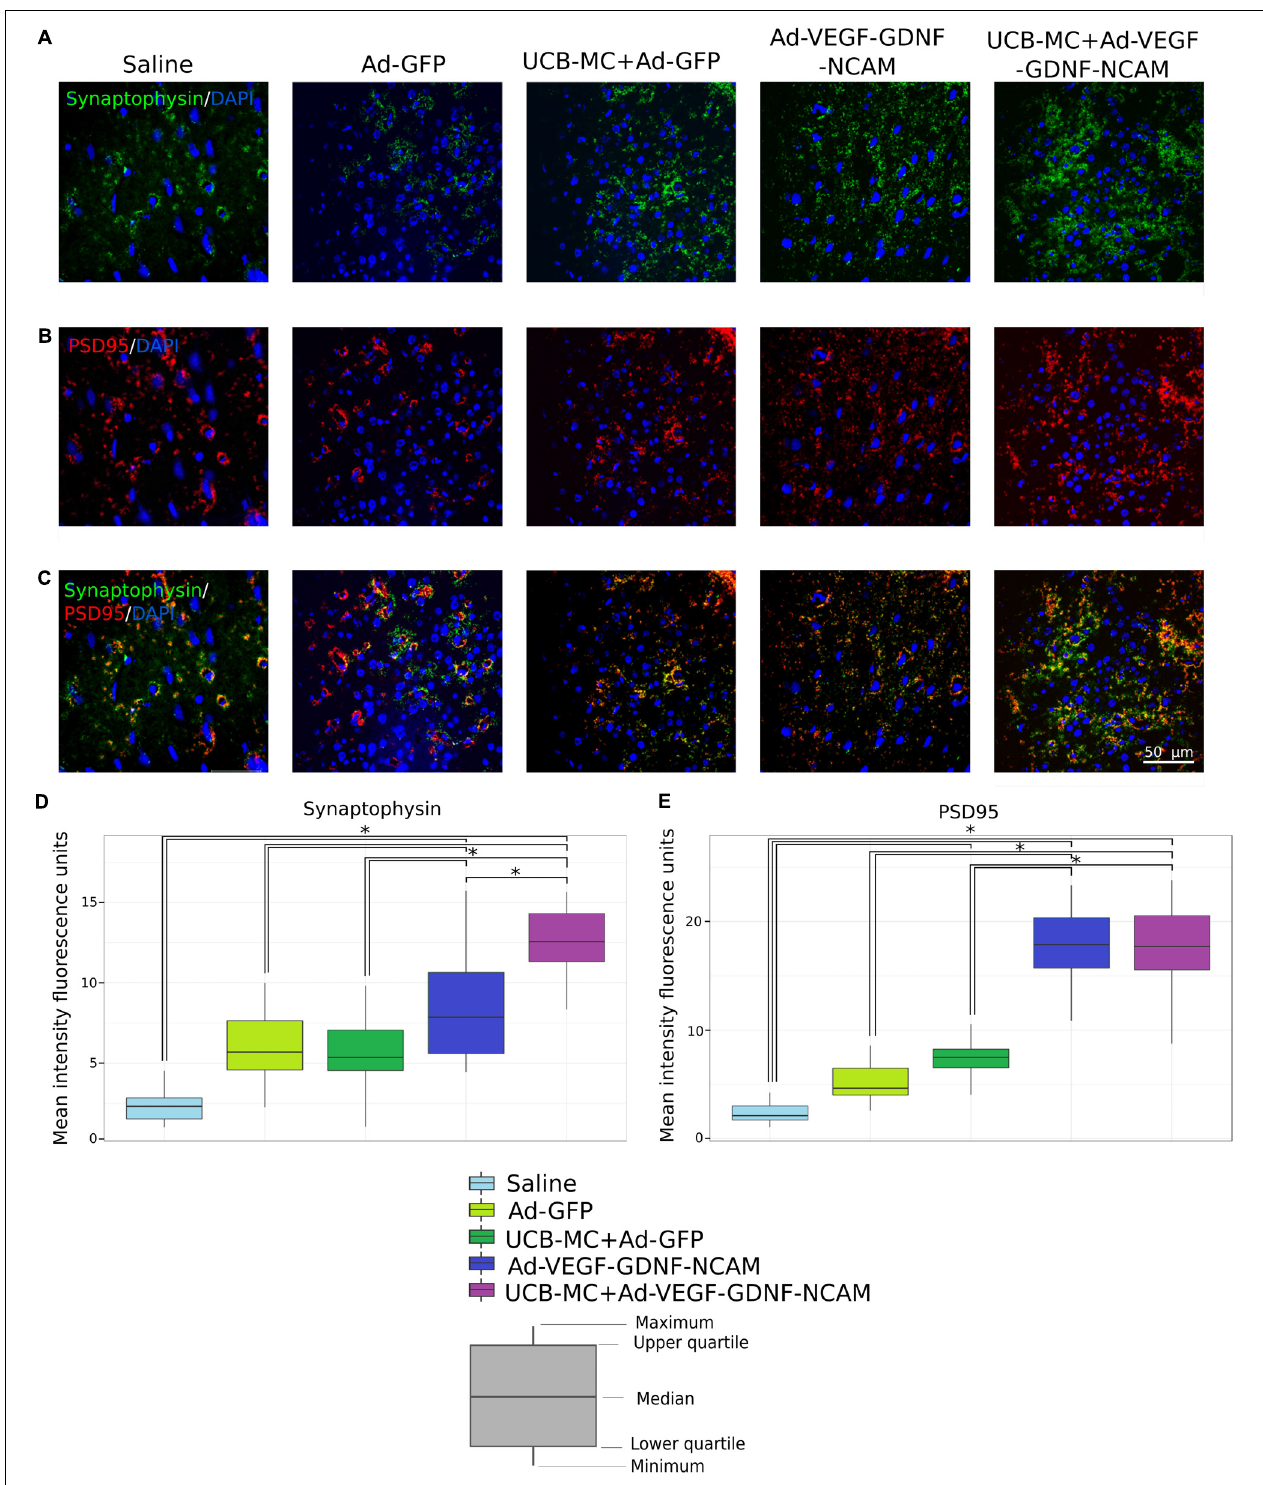
FIGURE 3 | Immunoexpression of synaptic proteins in brain cortex 21 days after the distal permanent occlusion of the MCA. (A,B) Immunofluorescent staining with Abs against synaptophysin (A) and PSD95 (B) . (C) Merged image of PSD95 (A) and synaptophysin (B) immunoexpression. Nuclei (blue) were counterstained with DAPI. Scale bar = 50 µ m. (D,E) Fluorescence density value of synaptophysin (D) and PSD95 (E) immunoexpression. Data are visualized using box plots. ∗ Difference between experimental groups, p < 0.05.